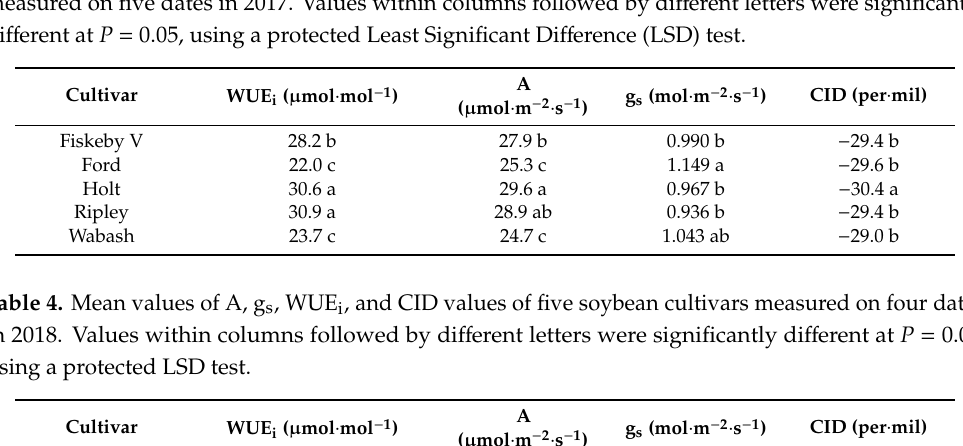
Figure 2. Intrinsic leaf water-use efficiency (WUE i ) in five cultivars of soybeans measured on four dates in 2018. Air temperatures (°C) during the measurements on each date are provided.